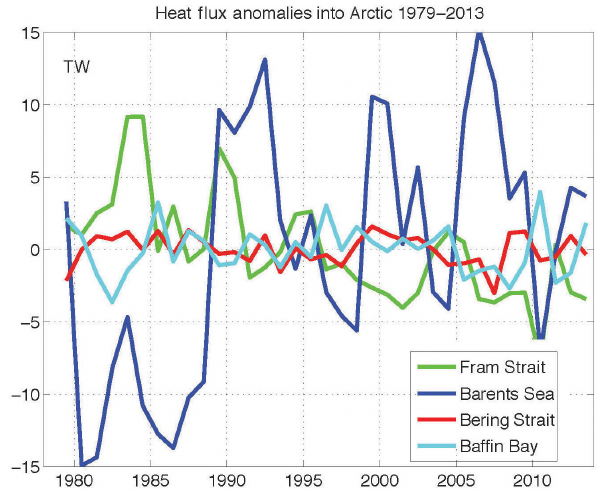
Figure 4. Heat flux anomalies (seasonal cycle removed) across key Arctic straits, as indicated in Fig. 2. The units are of the y axis are terawatts